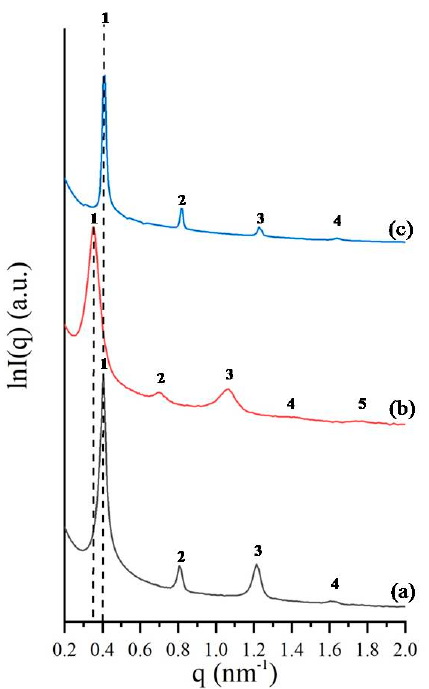
Figure 4. SAXS plots of lnI(q) versus q for the three different triblock terpolymer samples: ( a ) PS- b - PB 1,4 - b -PDMS (sample 1), ( b ) PS- b -PB 1,4 - b -PDMS (sample 2) and ( c ) PB 1,4 - b -PS- b -PDMS (sample 3). Supplementary Materials: The following are available online. Scheme S1: Synthetic routes of (a) PS- b -PB 1,4 - b - PDMS and (b) PB 1,4 - b -PS- b -PDMS triblock terpolymers. Figure S1: SEC chromatographs of the PS precursor (red), the diblock intermediate product of PS- b -PB 1,4 type (blue) and the final triblock terpolymer (sample 1) of the PS-